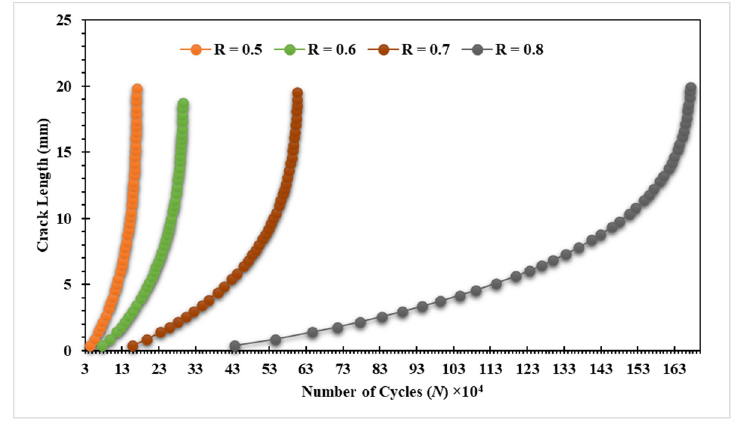
Figure 14. Predicted fatigue life cycles for specimen 3 with stress ratios, R = 0.5–0.8.